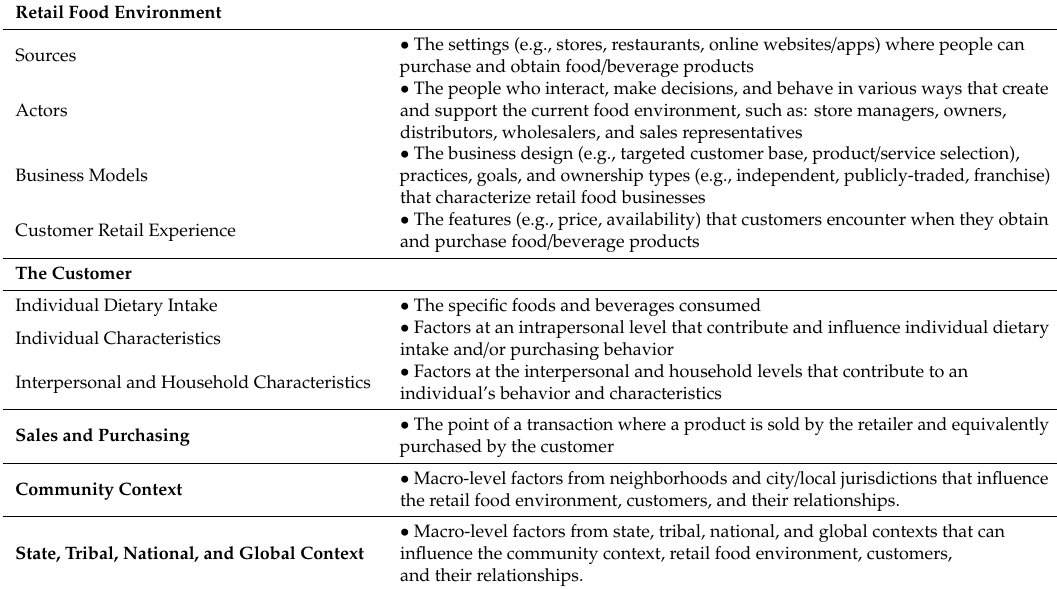
Table 1. Definitions for key model